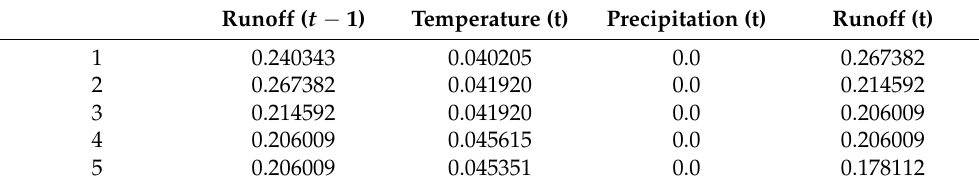
Table 2. Data conversion